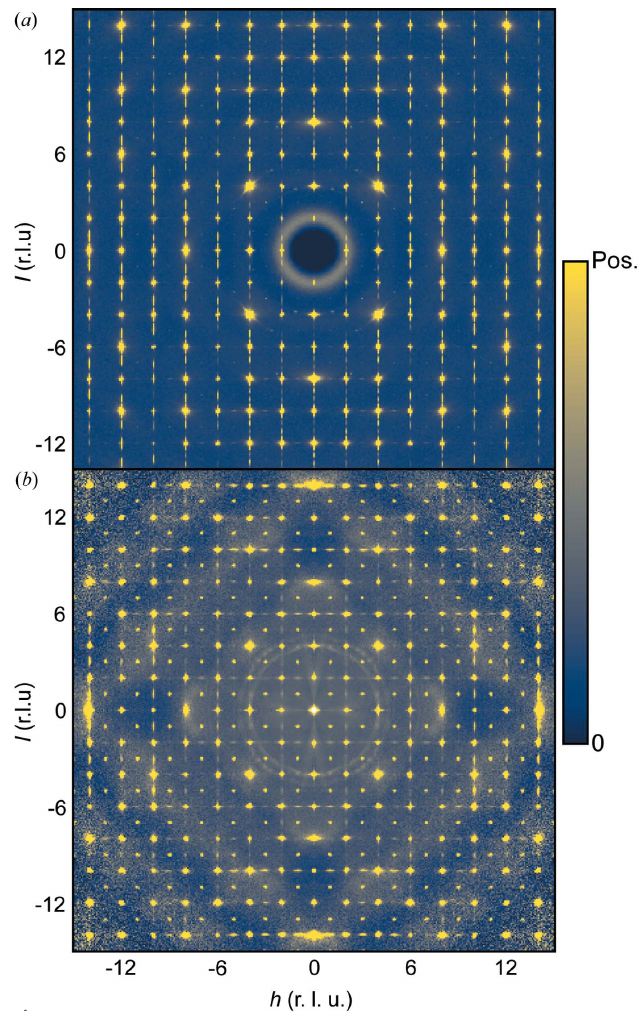
Figure 1 Experimental single-crystal ( a ) X-ray and ( b ) neutron scattering in the h 0 l plane. Distances in reciprocal space are given in reciprocal lattice units (r.l.u.). Both scattering patterns include Bragg and diffuse scattering. The data are shown on an arbitrary scale chosen to highlight the diffuse scattering